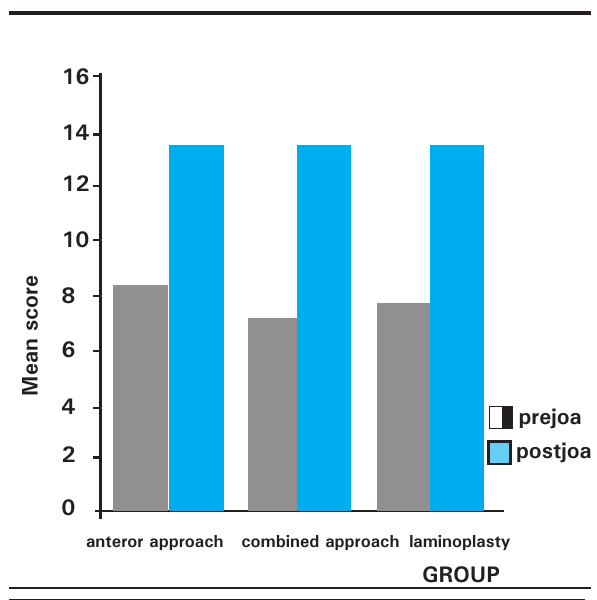
Figure 1. pre-operative and post-operative JOA score in patients for anterior approach , combined antero- posterior approach and laminoplasty.